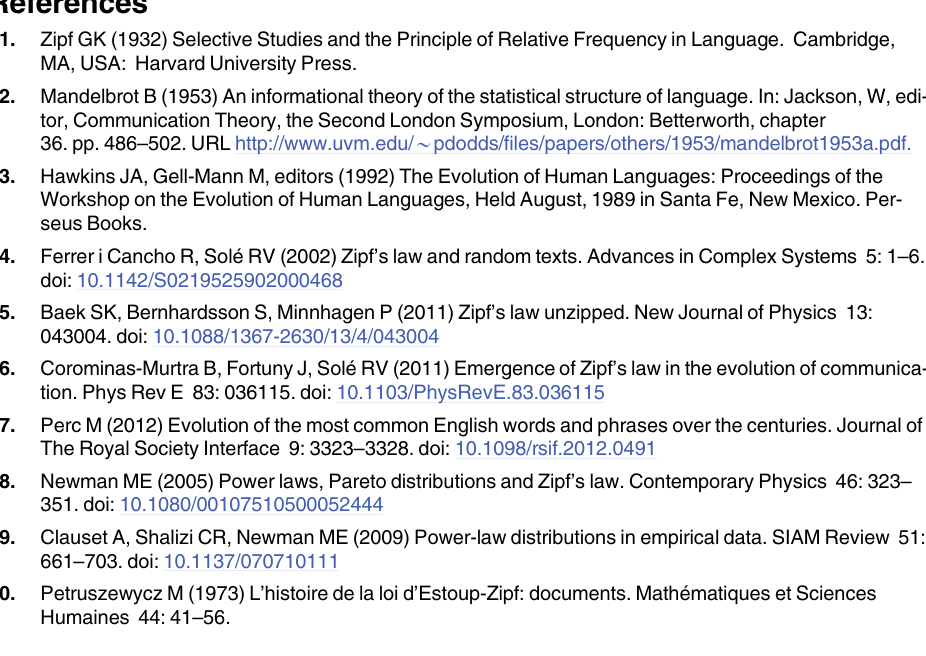
Figure S2. Comparison between the different models, Equations S1 – S5, and the frequency of rank distribution. We use the data for the year 2000 and all languages under consideration. The logarithm base 10 of the ratio of the observed values and the model is plotted. It can be ap- preciated that different models fit better in different regions. However there is no model that fits all languages and all regions much better than the others. Figure S3. Rank variations in time of twenty words from three different scales for English. Figure S4. Rank variations in time of twenty words from three different scales for German. Figure S5. Rank variations in time of twenty words from three different scales for French. Figure S6. Rank variations in time of twenty words from three different scales for Italian. Figure S7. Rank variations in time of twenty words from three different scales for Spanish. Figure S8. Rank variations in time of twenty words from three different scales for Russian. Figure S9. Rank variations in time of twenty words from three different scales for our simulated language. Figure S10. Distribution of relative flights for all languages studied. A similar plot as the one presented in Fig. 5 is shown for other languages. The same color coding and details are used. Figure S11. Correlations for relative frequency changes for different languages. Black line shows correlations for simulated